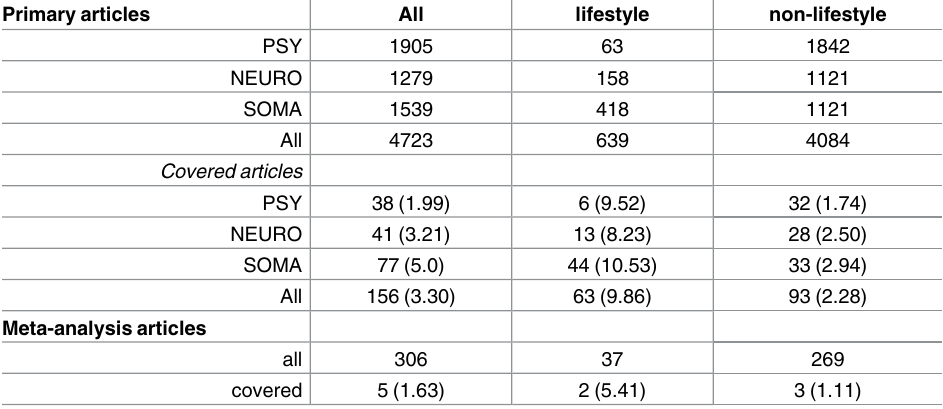
Table 1. Number of primary articles included in meta-analyses and number of primary articles cov- ered by newspapers classified by domains and association types. Primary